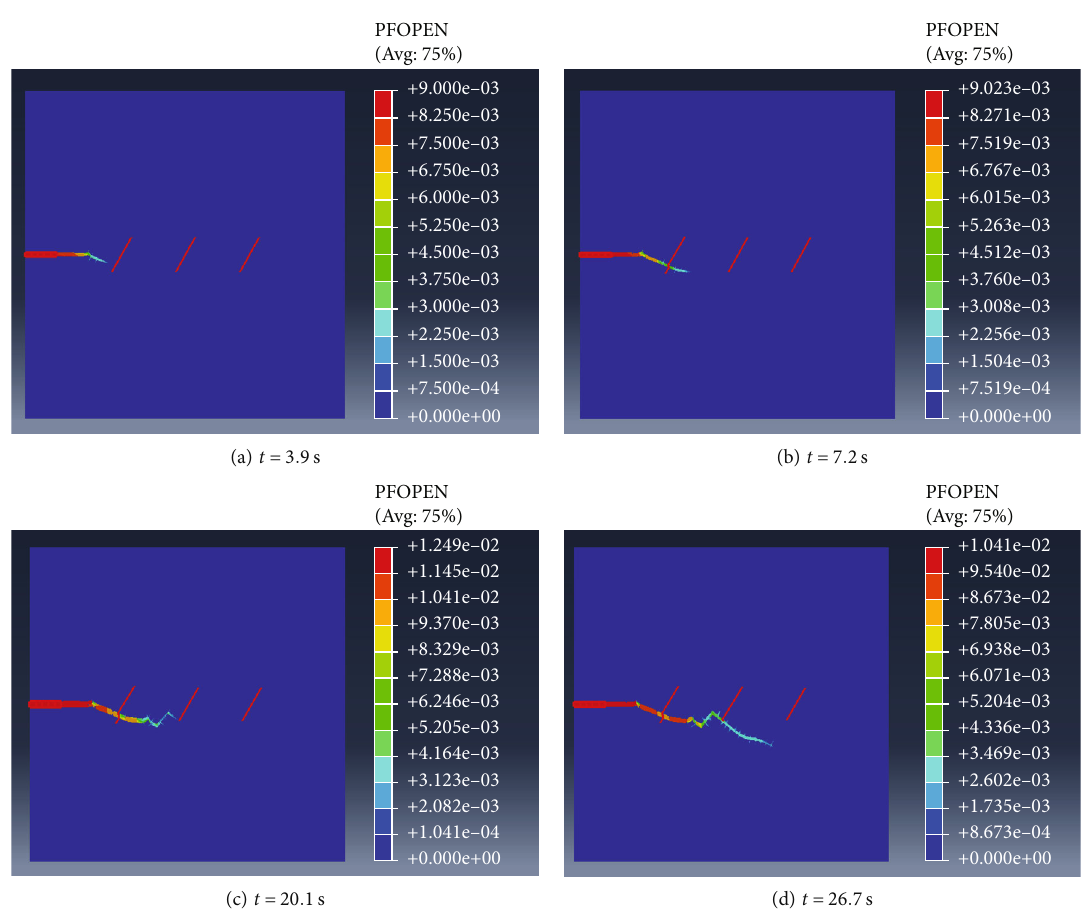
Figure 33: HF propagation at the NF approaching angle of 60 ° and under stress anisotropy coe ffi cient of 0.3.